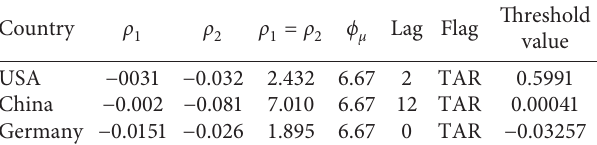
Table 4: Estimated equations using threshold cointegration test and consistent estimates (based country: